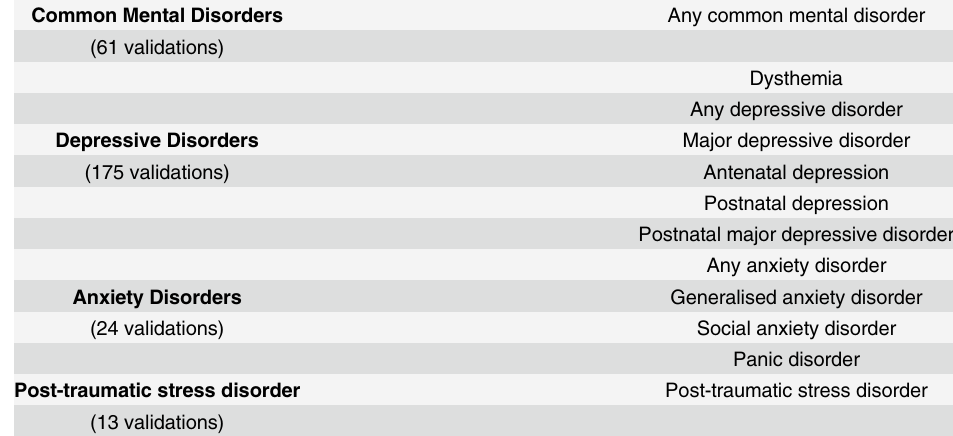
Table 2. Disorders for which screening tools were validated by studies included in this review.